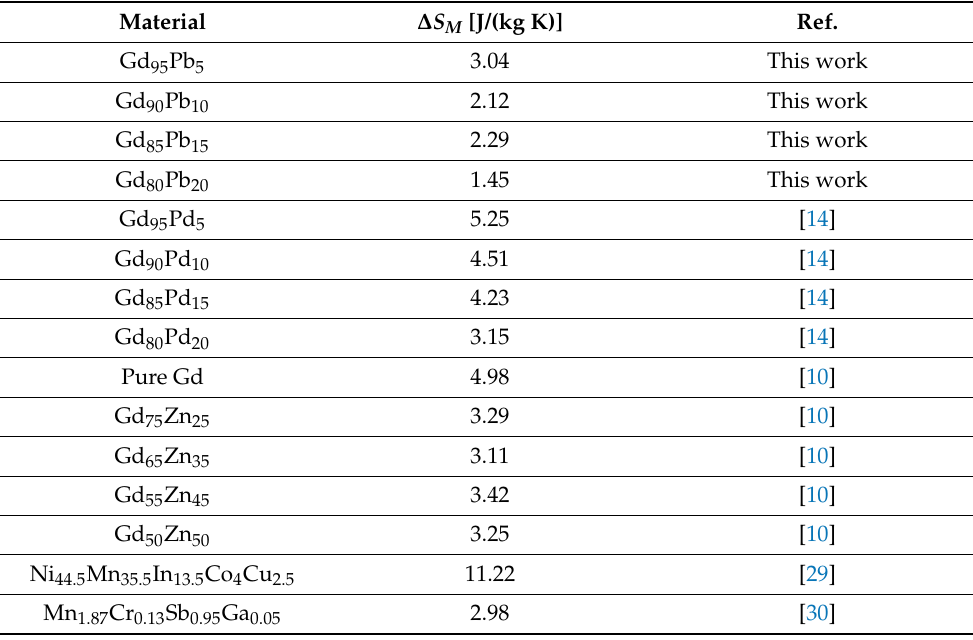
some other magnetocaloric materials under ∆ ( µ 0 H ) = 0–2